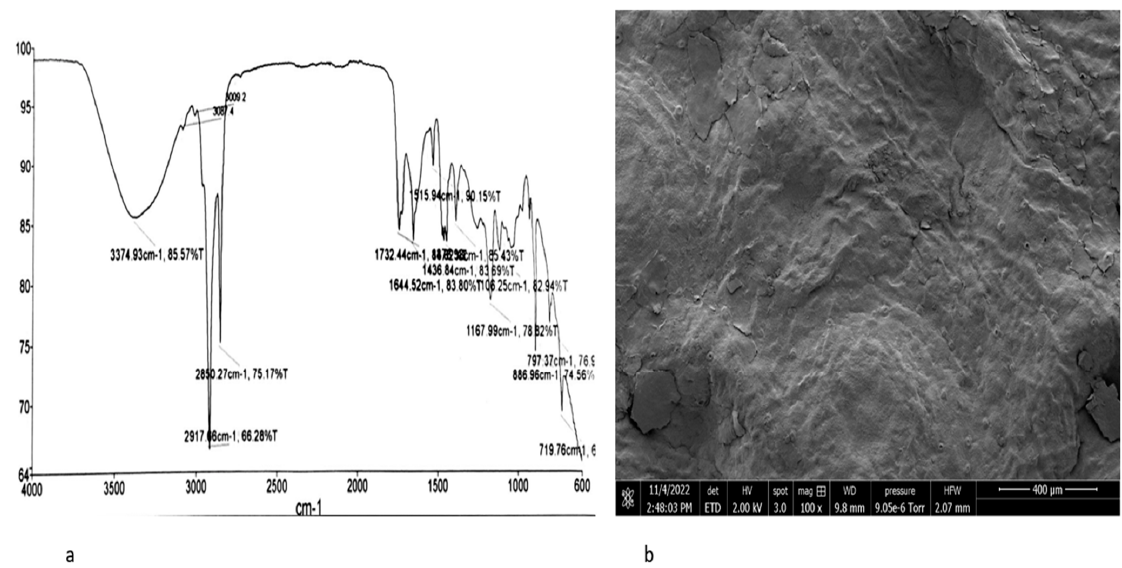
Figure 3. FTIR spectrum ( a ) and SEM image ( b ) of raw orange peel (this study). The SEM image of raw orange peel in Figure 3b shows a clean, smooth, and non- porous structure. The components of orange peel, including cellulose, hemicellulose, lig- nin, and pectin, are the reason for the smooth surface structure. Smooth surfaces have low adsorption uptake due to the reduced number of active sites available for the adsorption of contaminants, and do not allow significant binding of contaminants, hence the reason